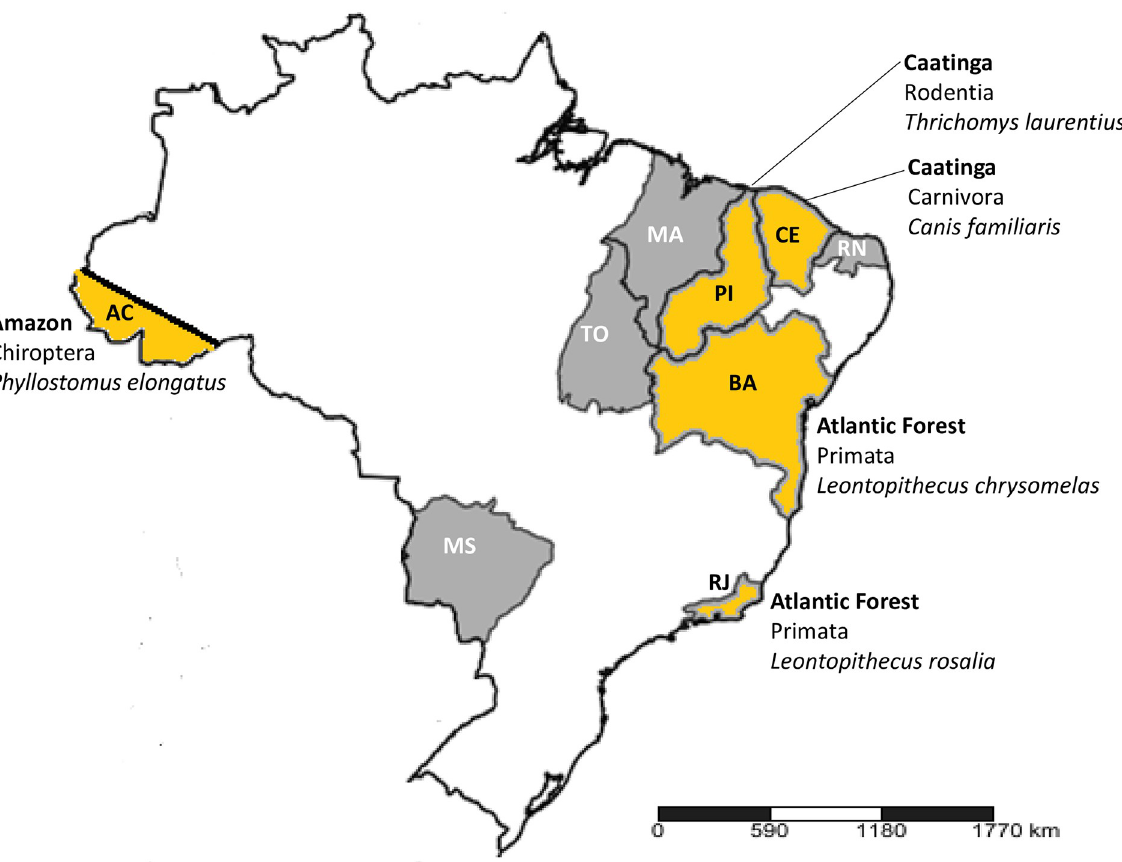
Fig 1. Map of Brazil showing origins of mammalian serum samples. States and biomes from which Chagas Sero K -SeT positive samples were identified are shown in orange; states from which no positive samples were identified are shown in grey. Abbreviations: AC, Acre; BA, Bahia; CE, Ceara´; MA, Maranh ã o; MS, Mato Grosso do Sul; PI, Piauı´; RJ, Rio de Janeiro; RN, Rio Grande do Norte; TO, Tocantins.